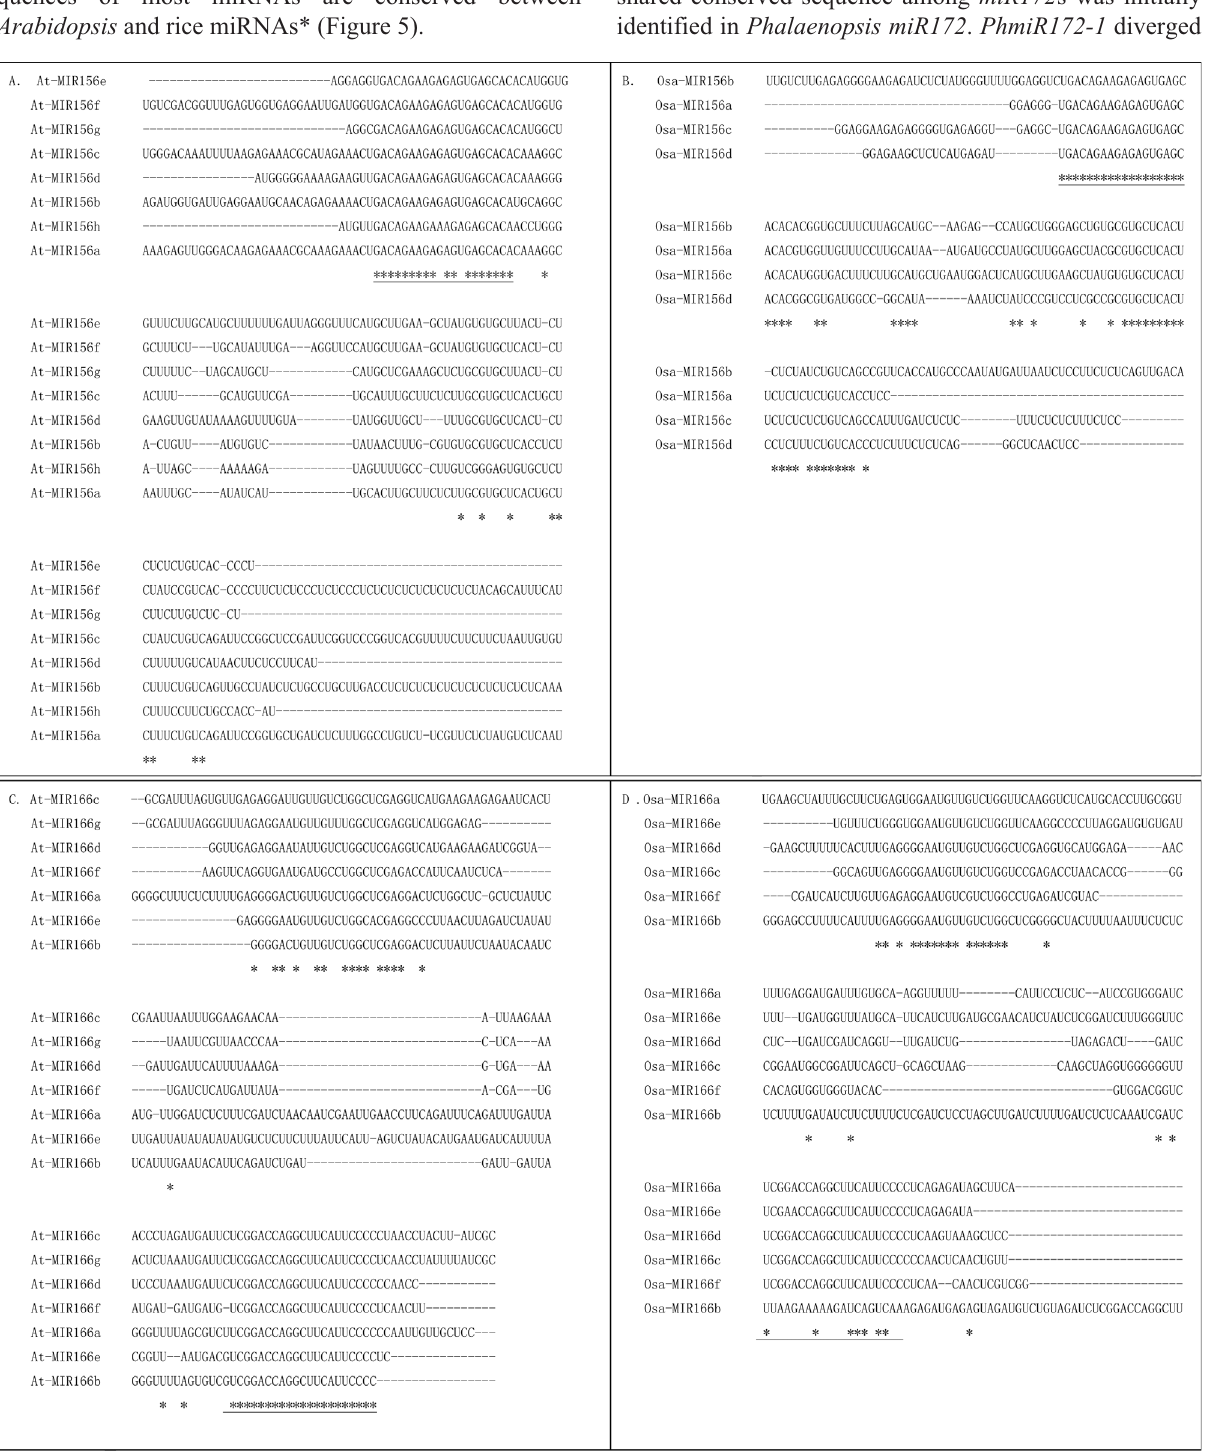
Figure 5 - Sequence alignment of Arabidopsis and Oryza miRNAs. *Conserved nucleotides. The core sequences of the miRNAs are underlined. At: Arabidopsis thaliana ; Os: Oryza sativa